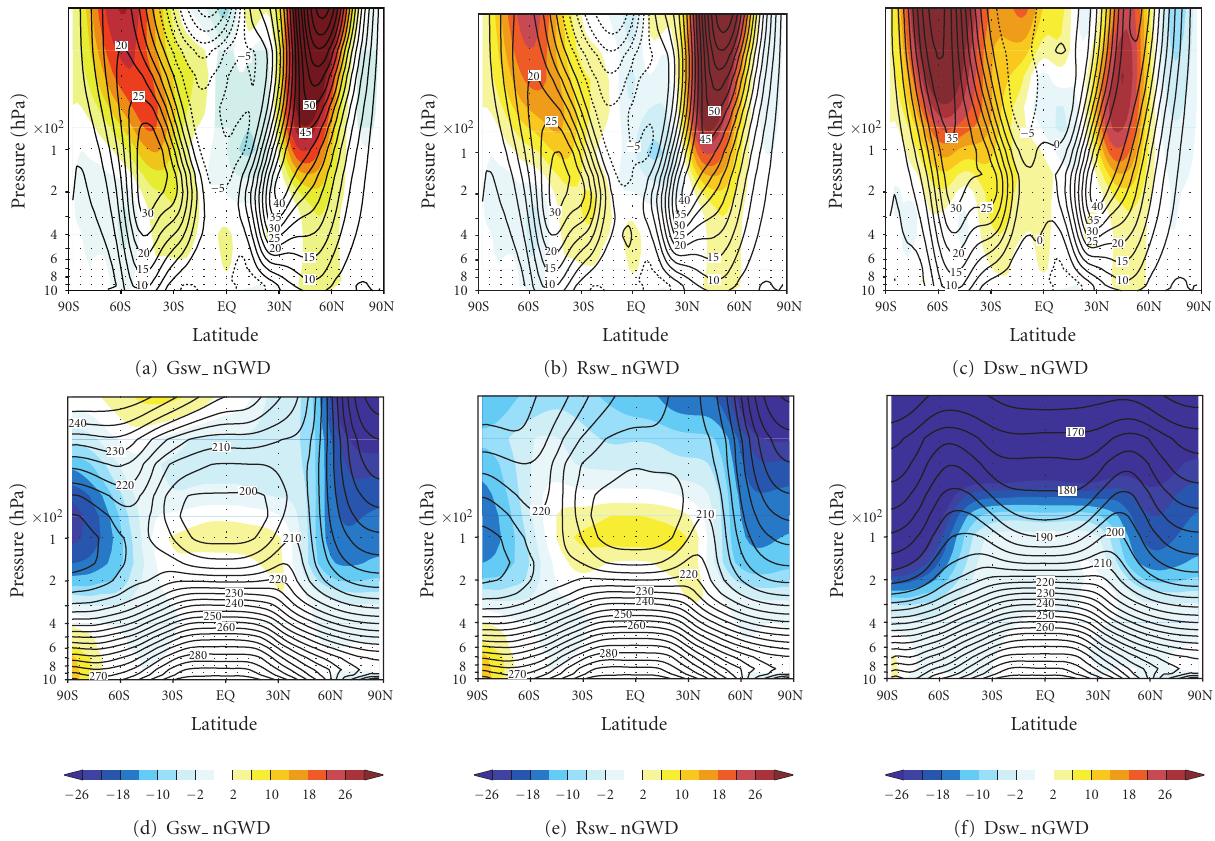
Figure 1: Three-winter ensemble averages (contours) of the zonal-mean zonal wind (upper panels) and temperature (lower panels) structures simulated from the (a), (d) Gsw nGWD, (b), (e) Rsw nGWD, and (c), (f) Dsw nGWD experiments with the earlier version of global WRF without the KA GWDO implementation. Di ff erences from the NCEP reanalysis (R2) are color